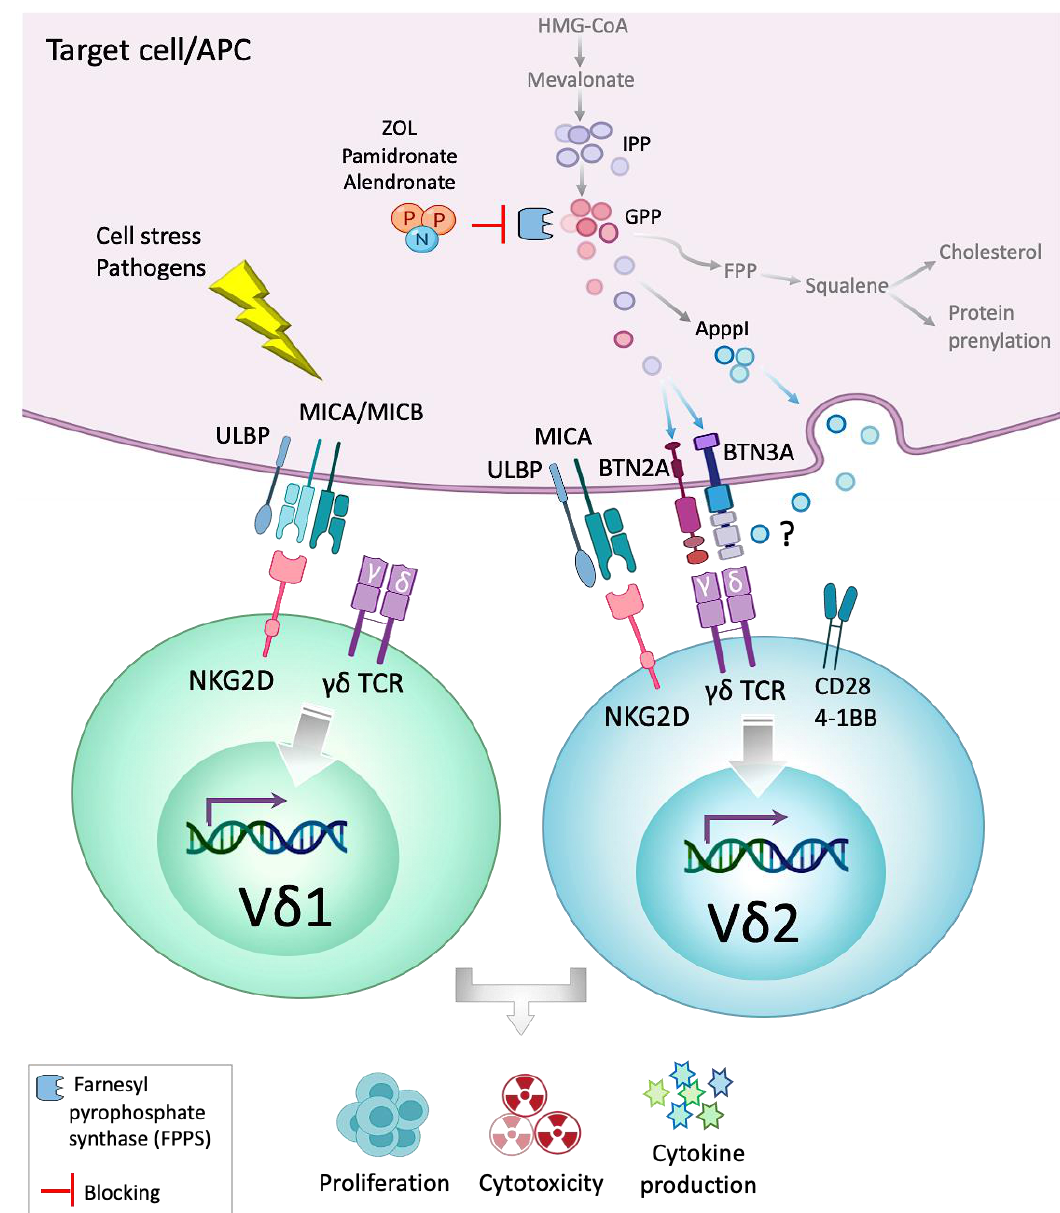
Figure 1. Mechanisms of γδ T cells activation. Bisphosphonates (BP) and nitrogenous-BP (N-BP) block the farnesyl pyrophosphate synthase (FPPS) enzyme in isoprenoid biosynthesis pathway in target cell or antigen presenting cells (APC) which leads to the accumulation of isopentenyl pyrophosphate (IPP) and its metabolites. IPP and geranyl pyrophosphate (GPP) react with cytoplasmic tail of butyrophilin-3 subfamily molecules (e.g., BTN3A1) and stir a change which is detectable by γδ TCR. IPP metabolites can also be converted into an ATP analog (ApppI). ApppI can be presented at the cell surface and be recognized by the γδ TCR; however, the molecular mechanism of this process is not yet clear. Some of the known ligands for V δ 1 and V δ 2 T cells are shown here. Cell stress and bacterial pathogens induce expression of MHC class I chain-related protein A and protein B (MICA / MICB) molecules which react with NKG2D on V δ 1. MICA also binds to NKG2D on V γ 9V δ 2 T cells. Several members of BTN family such as BTN3A1, BTN3A2, and BTN2A can bind to V δ 2 TCR and activate V δ 2 T cells. This activation